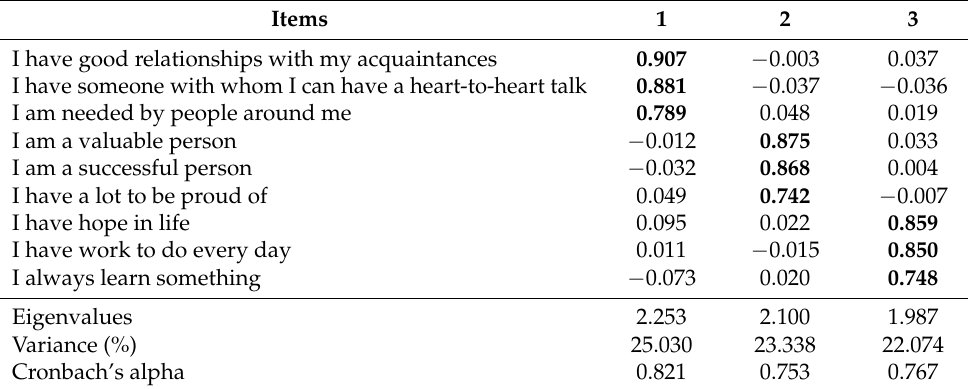
Table 2. Factor structure matrix for